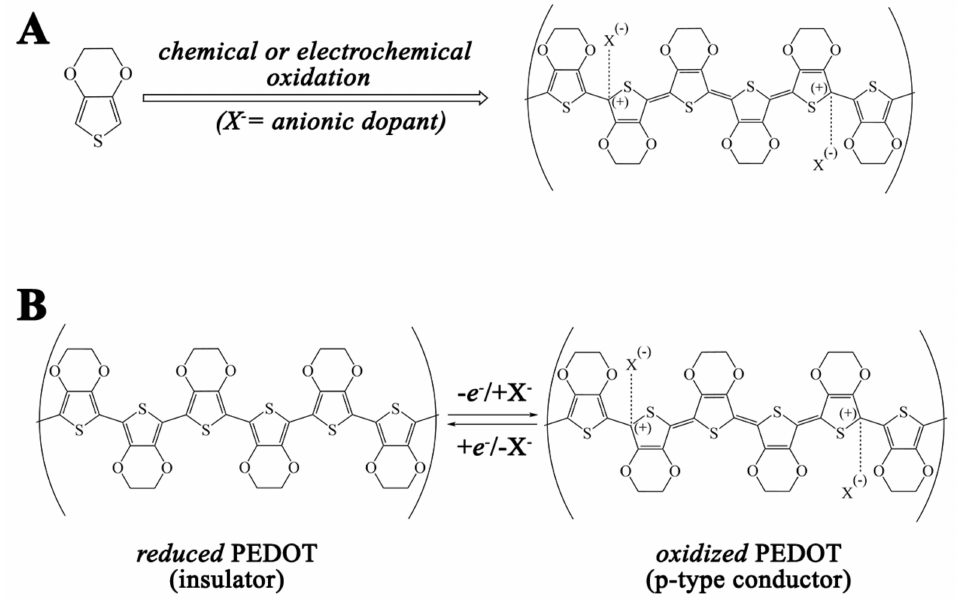
Figure 4. ( A ) general synthetic route to doped PEDOT:X (X = generic dopant) and ( B ) reversible switch between reduced and oxidized forms of